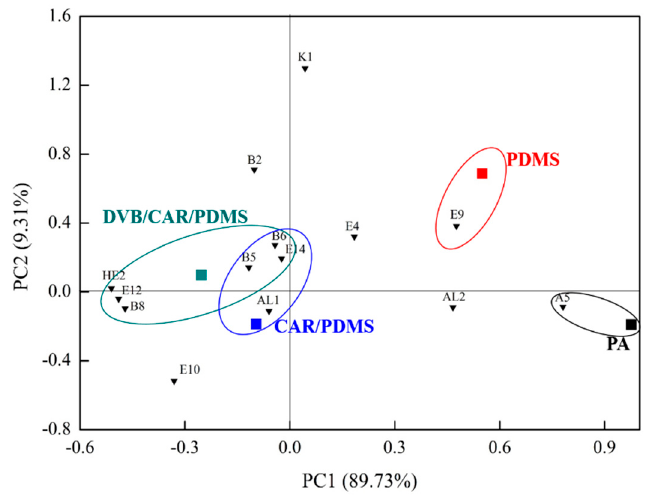
Figure 3 . PCA biplot showing relationship between the four fibers and 14 odor-active compounds (OAVs > 1) in proso millet wine.